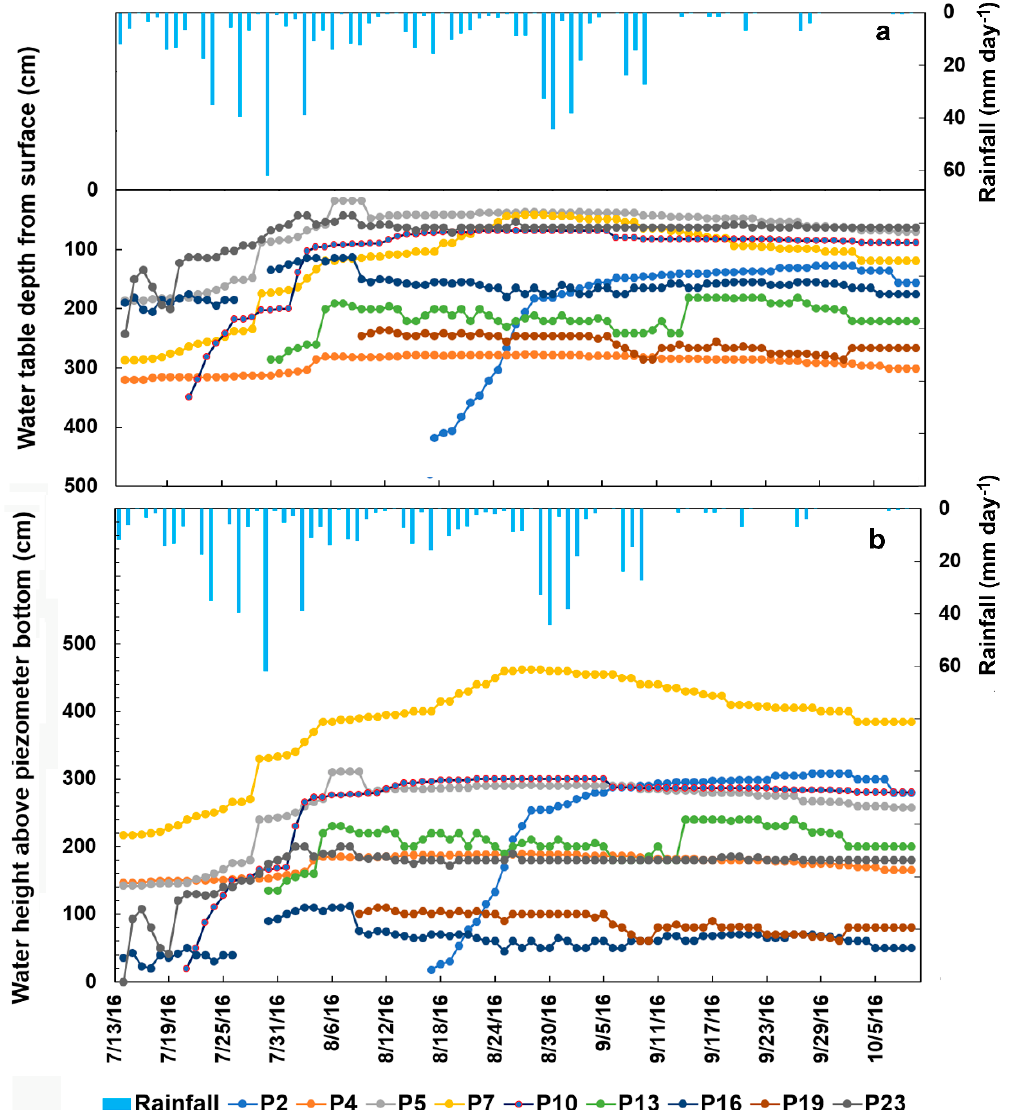
Figure 7. Shallow groundwater for installed piezometers in the Gomit watershed for the year 2016. The piezometers P4, P5, P7, P10, P16, and P23 were located downslope and the P2, P13, and P19 on the midslope. The remaining 14 piezometers at mid- and up-slope positions remained dry. The locations of the piezometers are depicted in Figure 1: ( a ) plotted as depth from the soil surface and ( b ) plotted as height above the bottom of the piezometer.